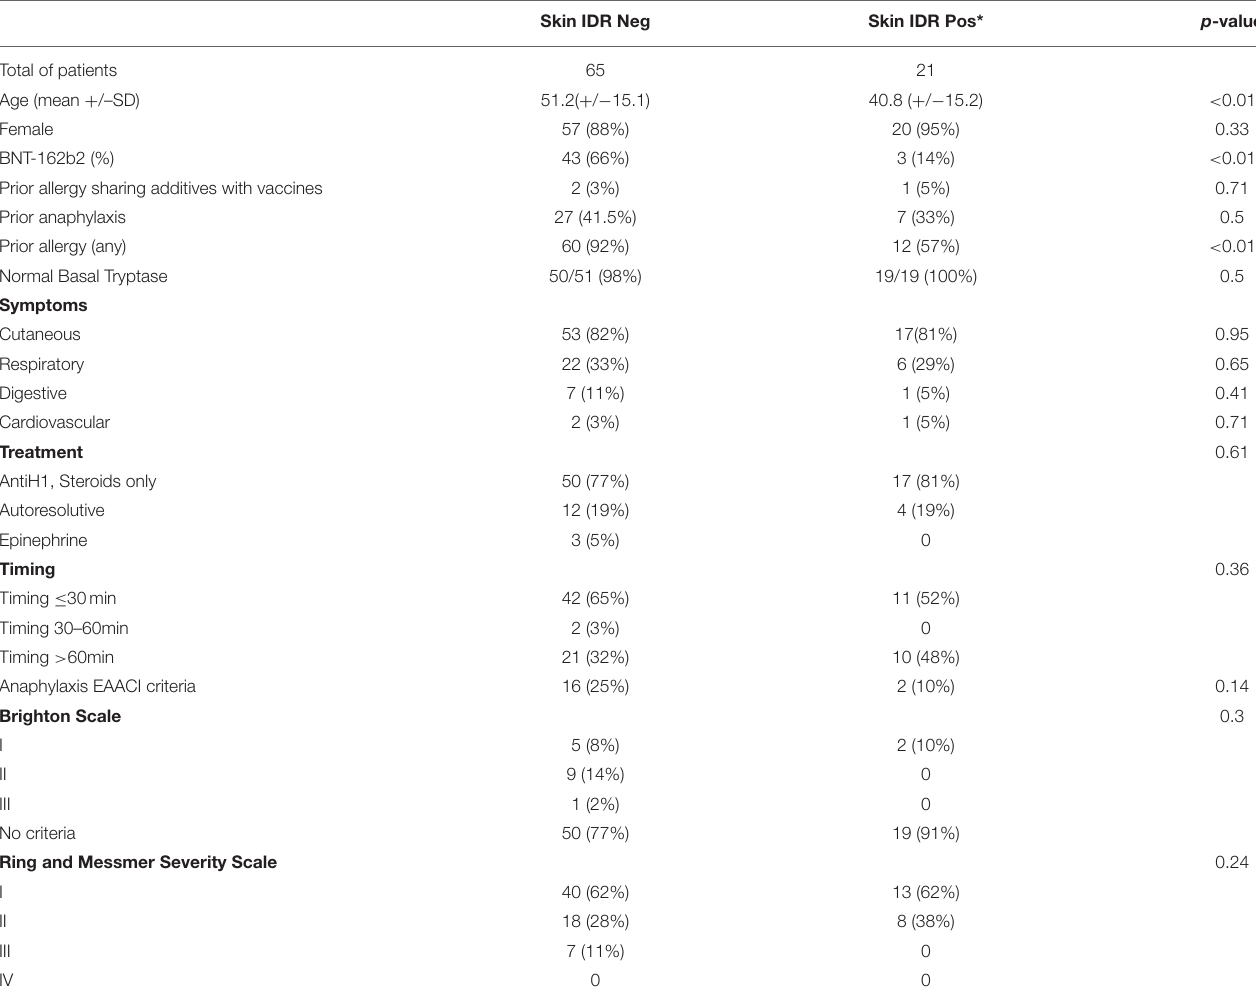
TABLE 3 | Characteristics of the 86 patients tested for the mRNA vaccines after experiencing a suspected allergy reaction immediately after